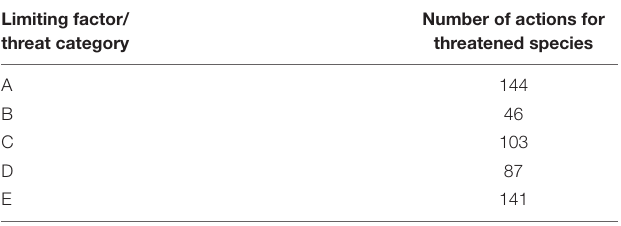
TABLE 1B | Number of threatened species, with associated cost reported, by limiting factor for the United States. Limiting factor/ threat category